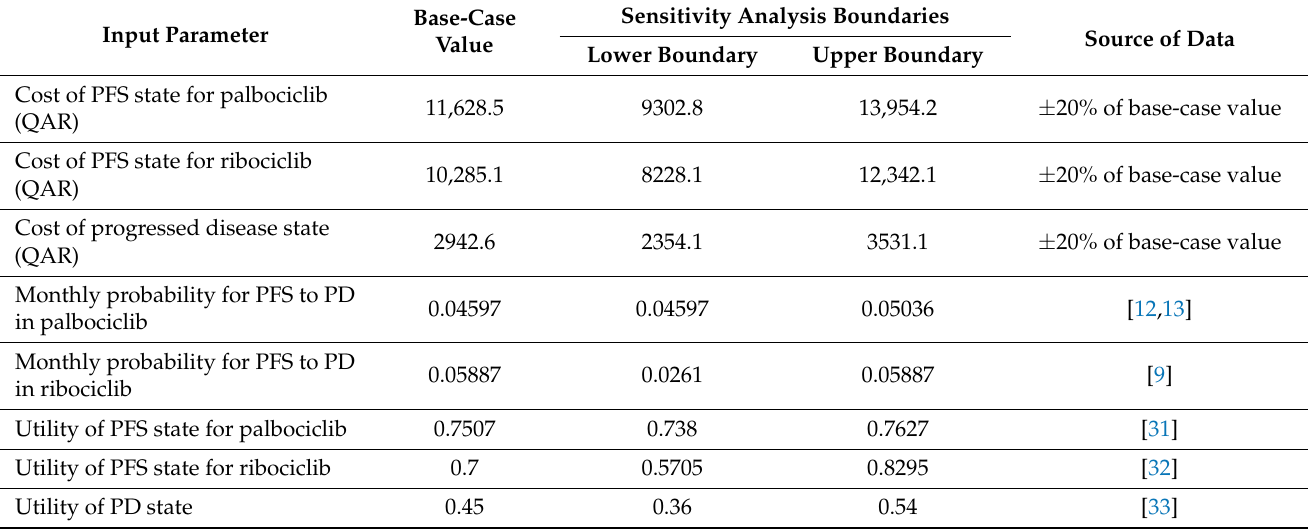
Table 2. Univariate deterministic sensitivity analysis (DSA) inputs.